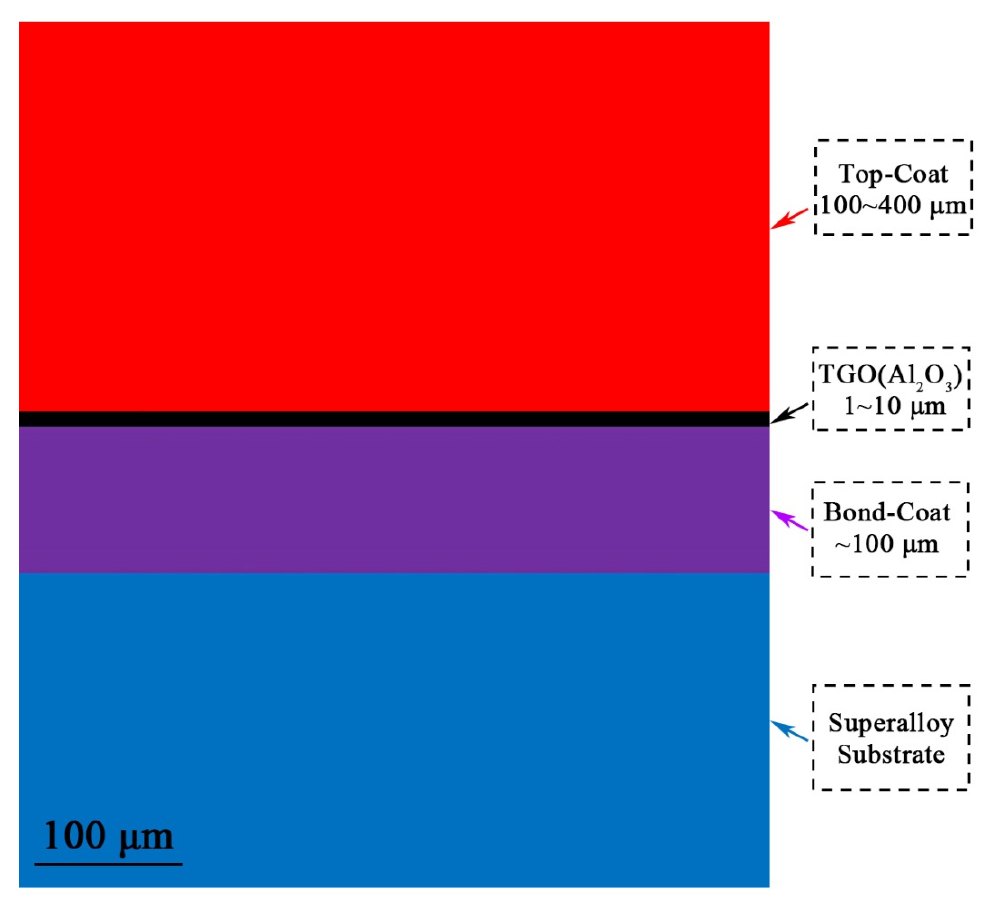
Figure 1. Schematic illustration of thermal barrier coatings.